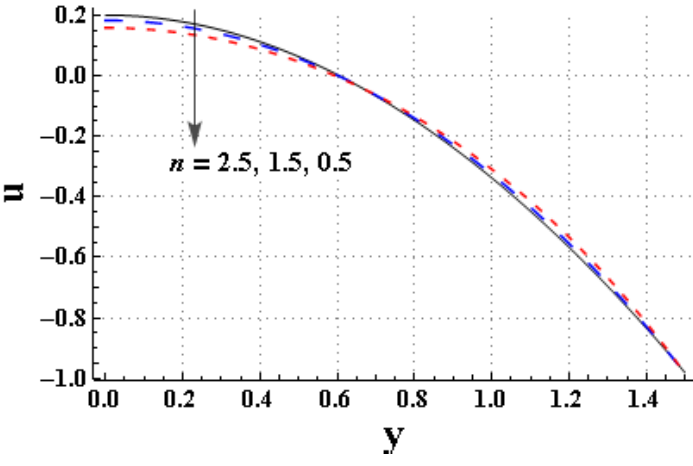
Figure 6. Effect of the power law index, n , on velocity, u